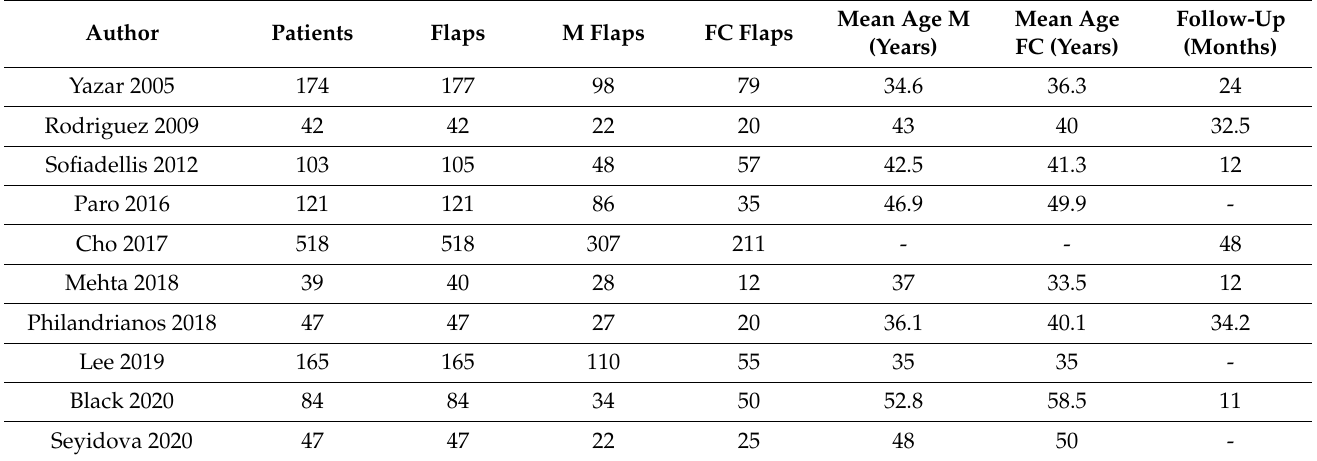
Table 1. Characteristics of the included